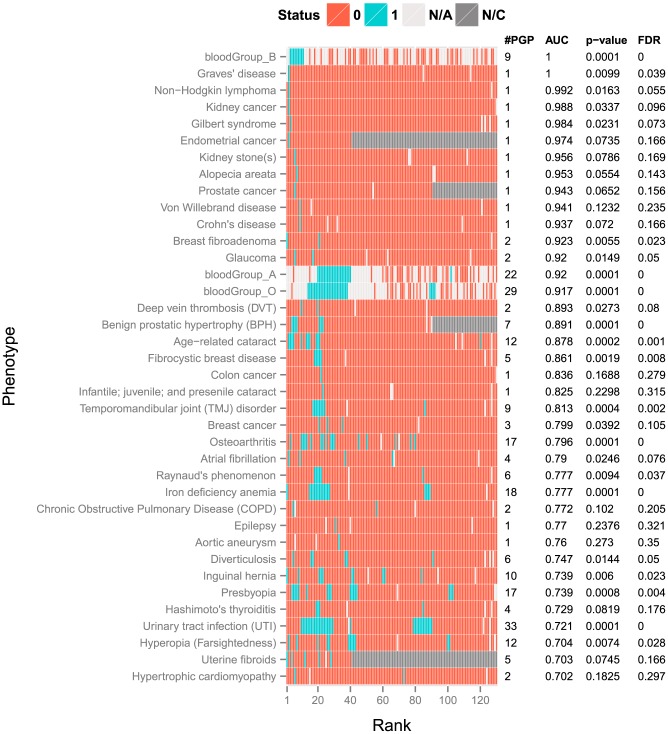
Prediction results of the model on 38 dichotomous phenotypes.Each row represents a clinical phenotype and consists of 130 cells, each of which represents a Personal Genome Project (PGP) participant. Cells in each row are ranked by the posterior probability that the participant has the phenotype. Cells are colored by true phenotypic status. Blue cells indicate that a participant has the phenotype, and red cells that a participant does not have the phenotype. If a cell is colored light grey, the true phenotypic status is unknown. If a cell is colored dark grey, the PGP participant is not considered in the evaluation because the phenotype is gender-specific. #PGP = number of participants in each row having the true phenotypic status. AUC = area under the receiver operating characteristic curve, a threshold-free metric of classifier performance. p-value and FDR = statistical significance of the AUC value, based on permutation testing.